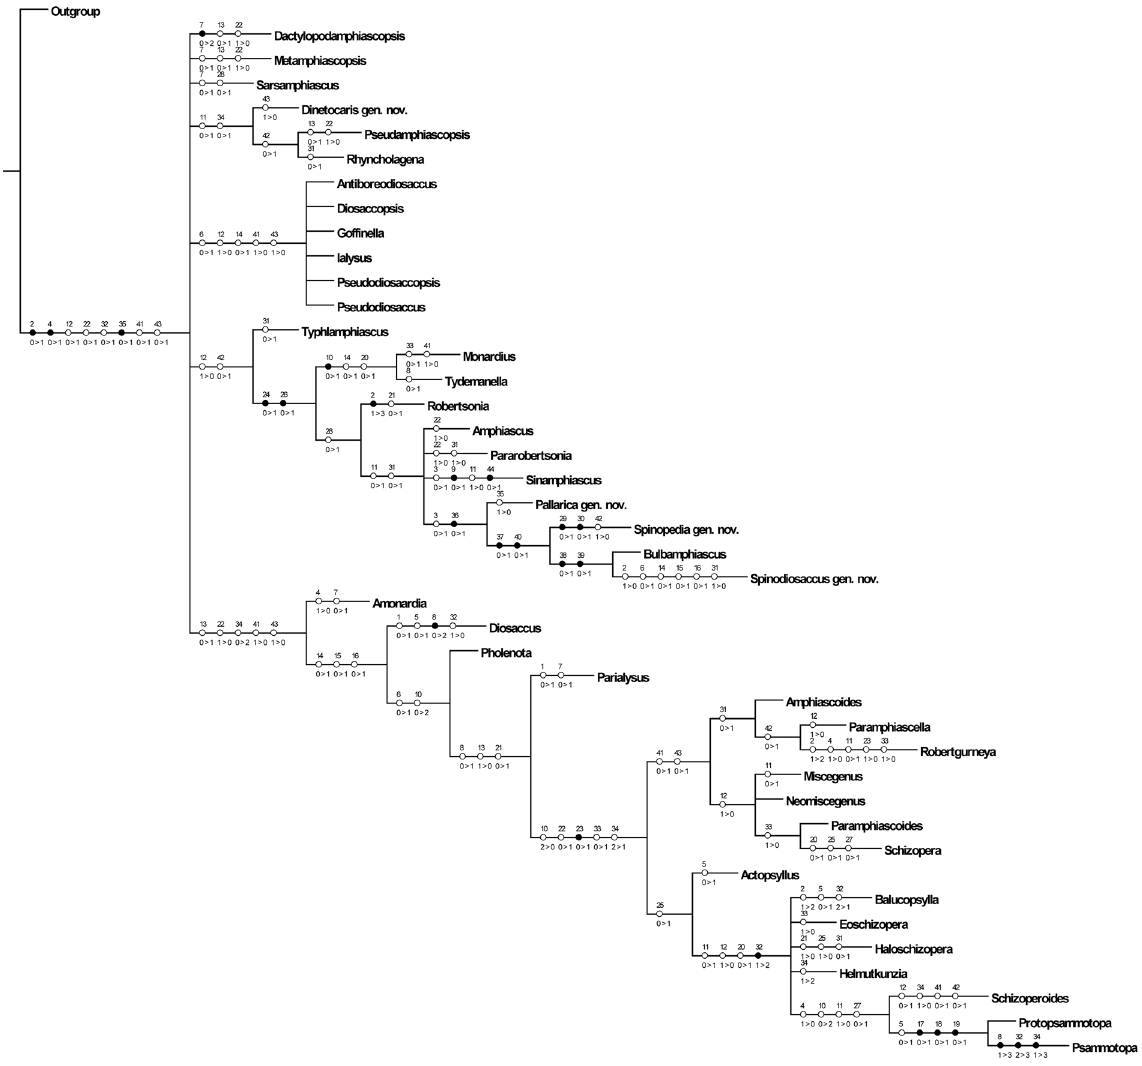
Fig. 19. Strict consensus cladogram of the generic relationships within the